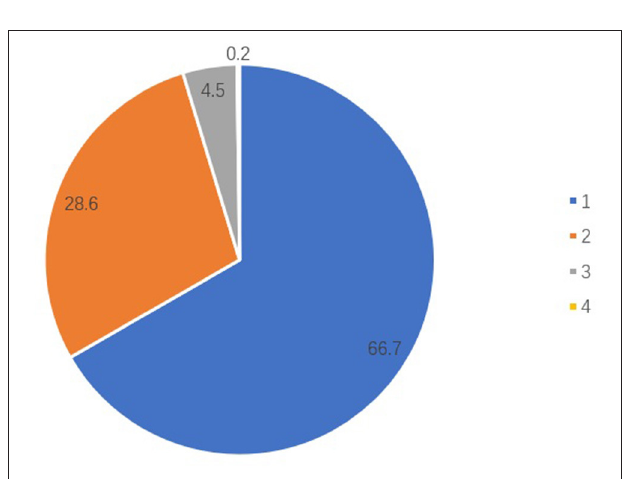
FIGURE 2 | The proportion of different severity grades in people with constipation.